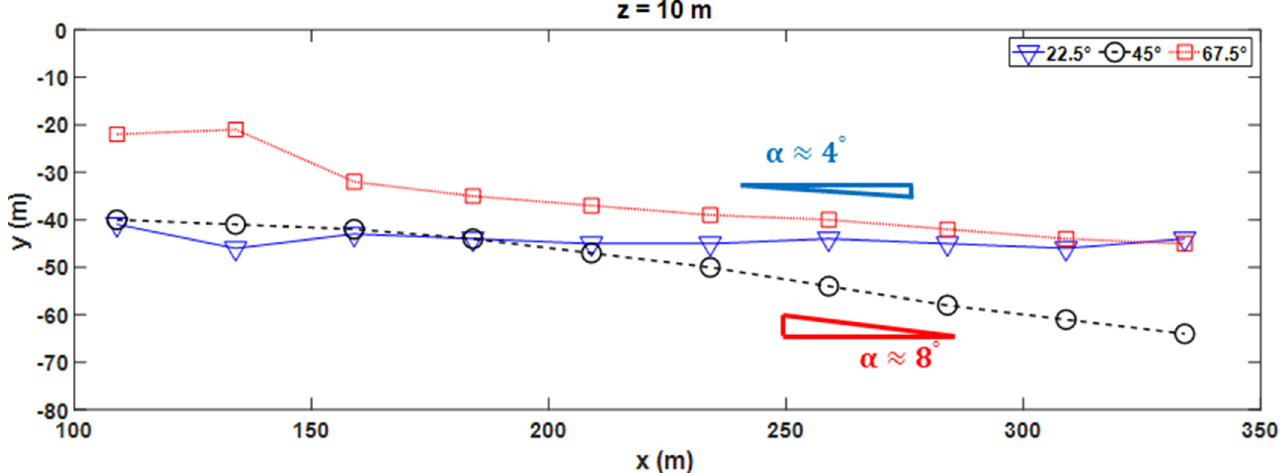
Figure 6. Trajectories of maximum deficit of mean along-wind velocity in the lateral direction at the height of 10